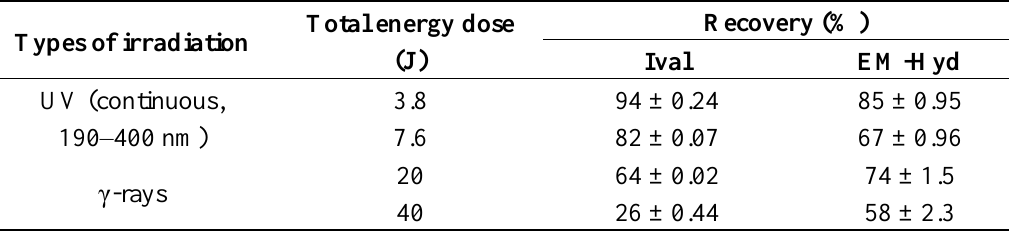
Table 1. Recovery of Ival and EM-Hyd after UV and γ-ray irradiation. Plus minus (±) represents the standard deviation of multiple analyses.